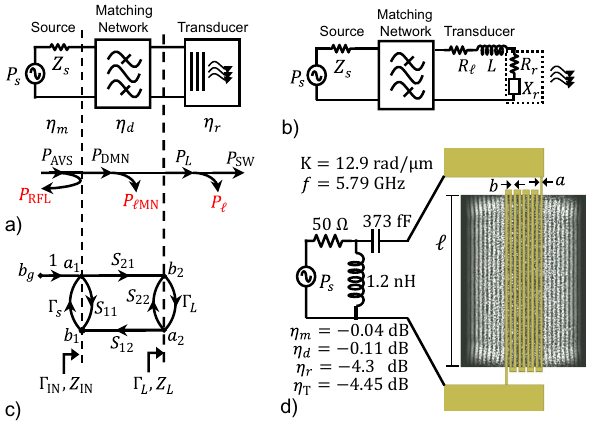
Figure 1. System-level model and example of efficient EM-to-spin-wave transducer. ( a ) Block diagram of the transducer system and the power flow through the system. ( b ) Lumped element approximation to transducer circuit model. The transducer consists of the electromagnetic circuit’s losses ( R ℓ ) and inductance ( L ) and the magnetic film’s radiation resistance ( R r ) and reactance ( X r ). ( c ) Signal flow graph for the transducer system. ( d ) Example transducer with matching network and corresponding efficiencies as described in “Efficient, narrowband multi-conductor